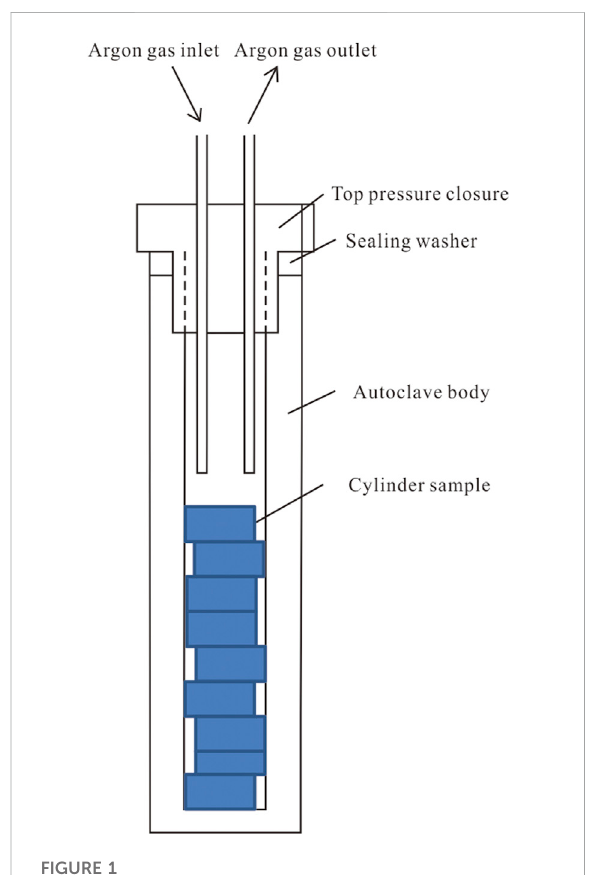
FIGURE 1 Internal structureof vesselfor thermal simulation experiment of block coal